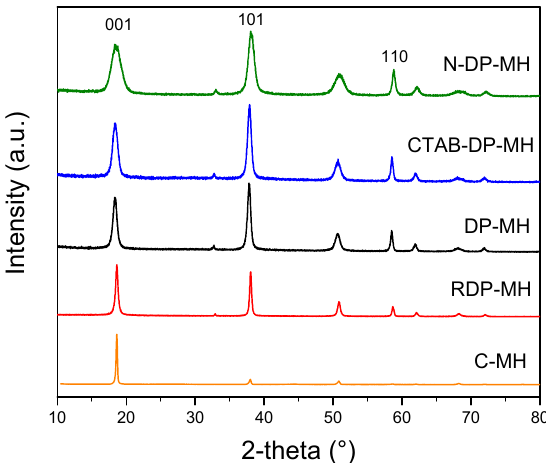
Figure 1. X-ray diffraction (XRD) analysis of investigated samples.